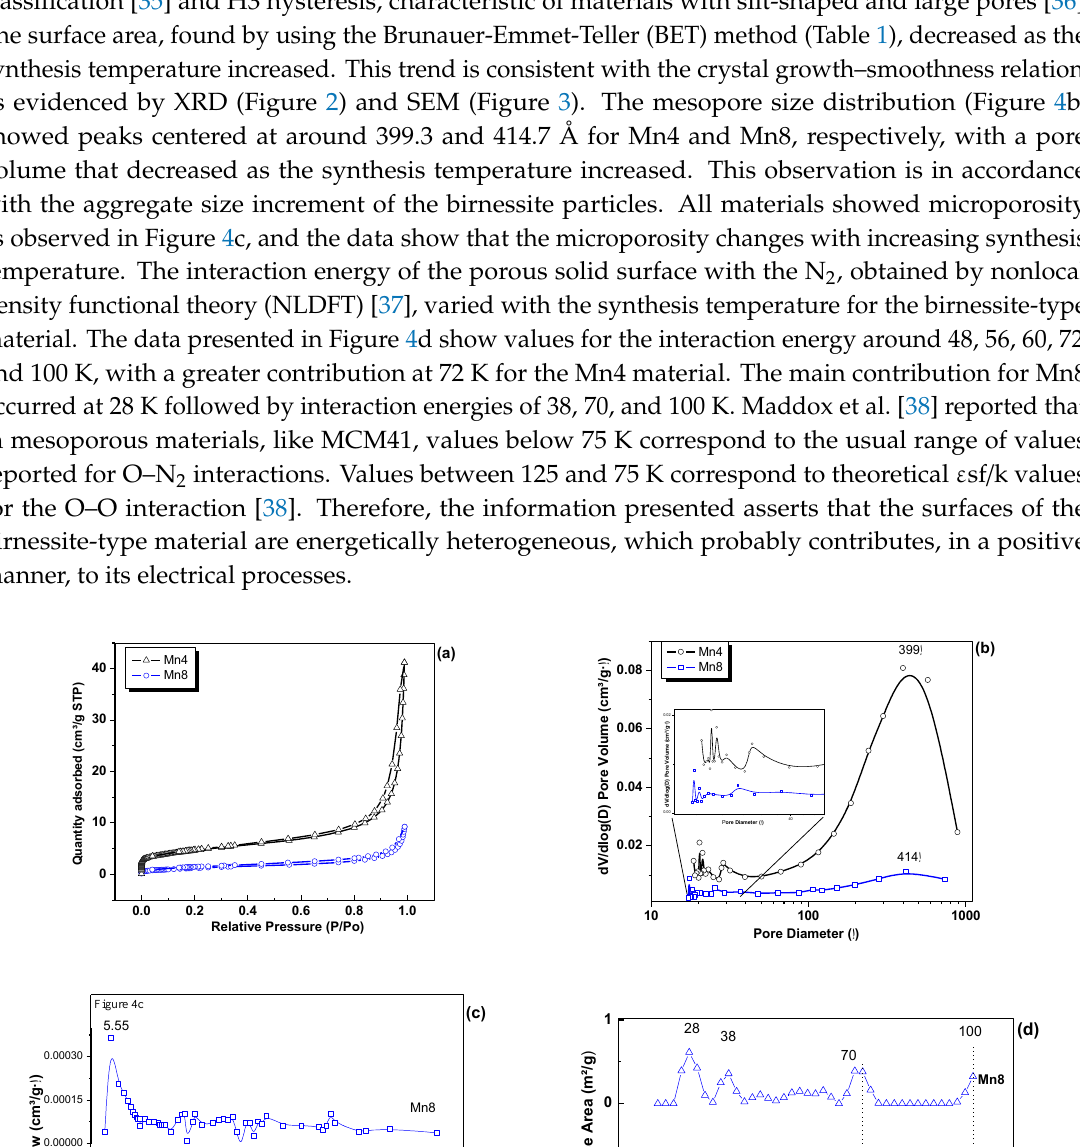
Figure 4. N 2 adsorption–desorption results: ( a ) N 2 isotherms, ( b ) mesopore size distribution by Barret– Joyner–Halenda (BJH), ( c ) micropore size distribution by Hovarth–Kawazoe (HK), and ( d ) interaction energy by nonlocal density functional theory (NLDFT).